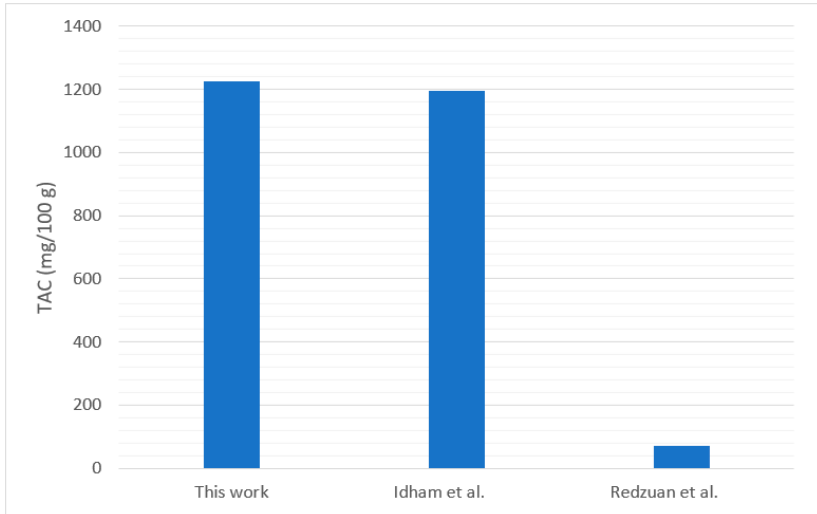
Figure 8. Comparison of the TAC recovery from roselle obtained in this study and in previous works [14,65].